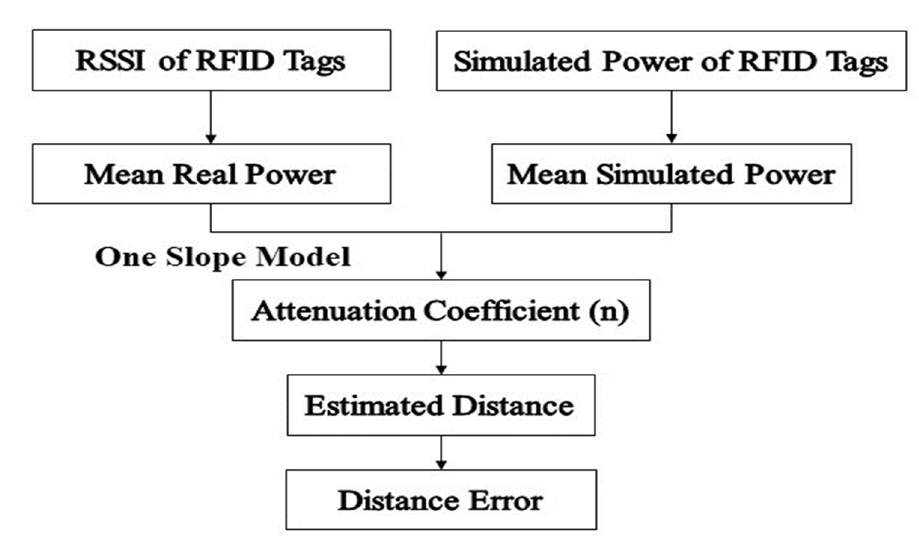
Figure 2. Steps for the estimated distance error calculation .